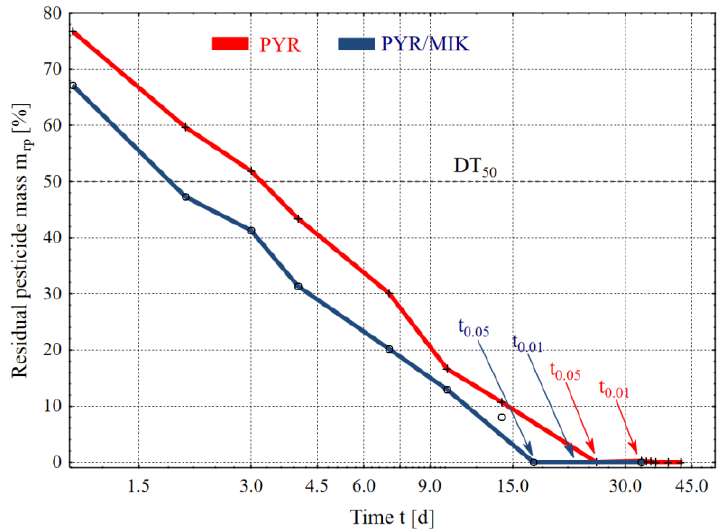
Figure 6. Mass deposition (% residual PYR mass) in microbe-free (PYR) and microbe-enriched (PYR/MIK) wastewater passed through the constructed wetland bed throughout the study period.